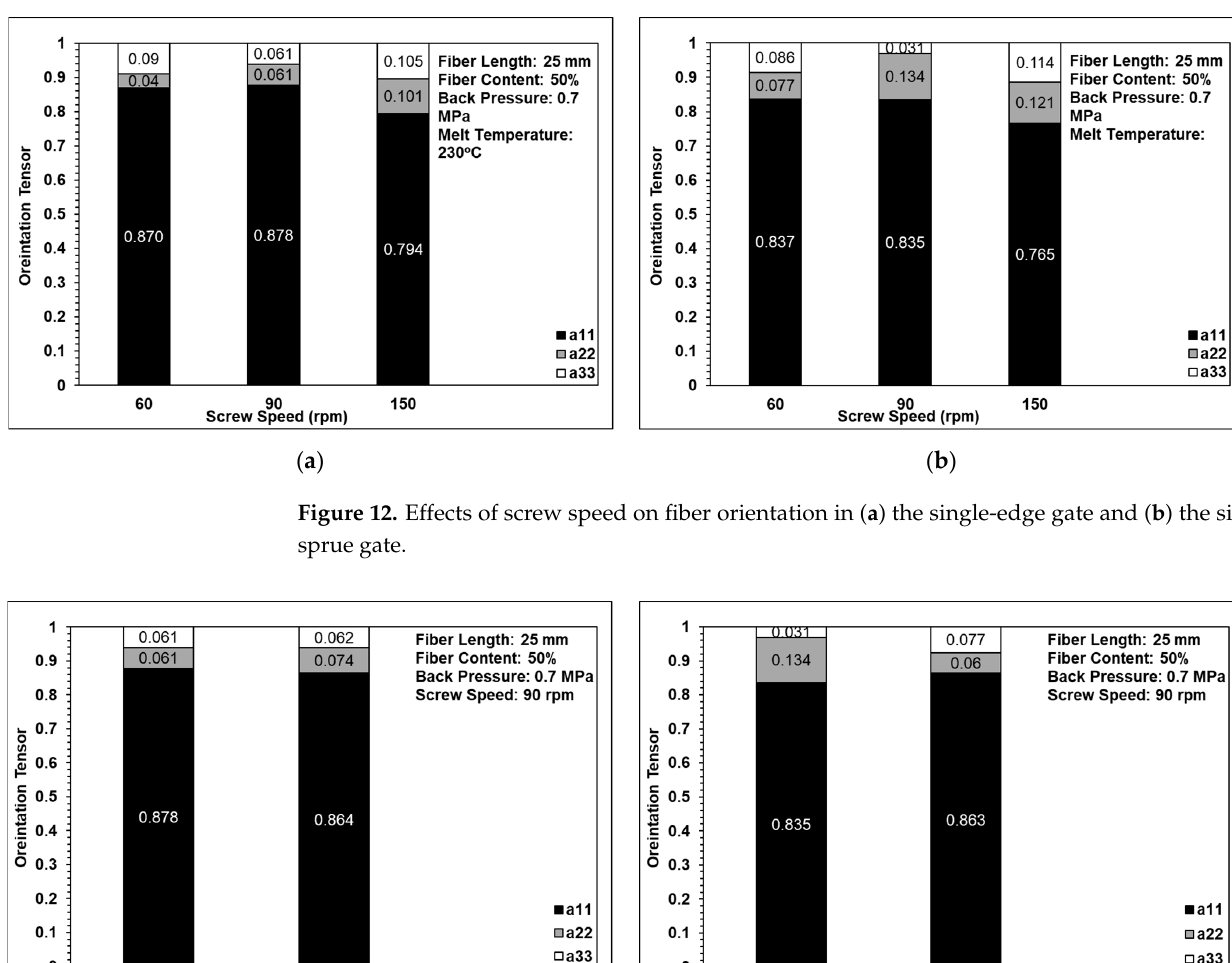
Figure 11. Effects of back pressure on fiber orientation in ( a ) the single-edge gate and ( b ) the single- sprue gate.